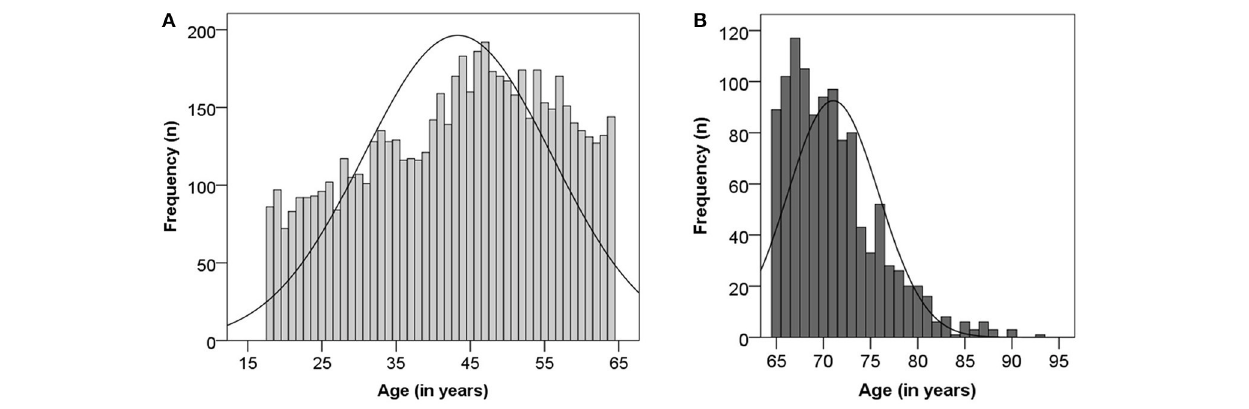
FIGURE 2 | Age distribution among adults (A) and the elderly (B)